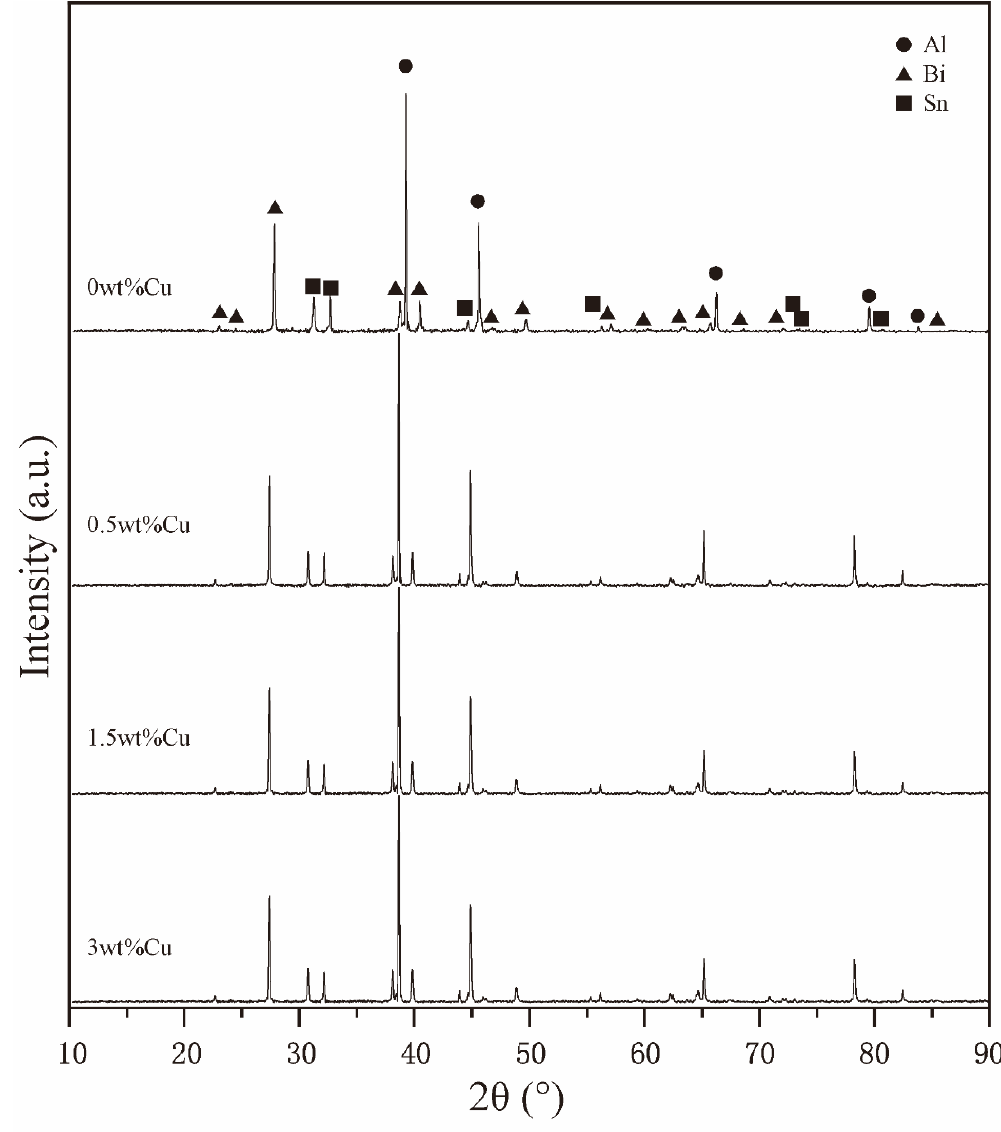
Figure 5. XRD patterns of the Al–10Bi–7Sn-xCu (x = 0, 0.5, 1.5, 3 wt%) composite powders.